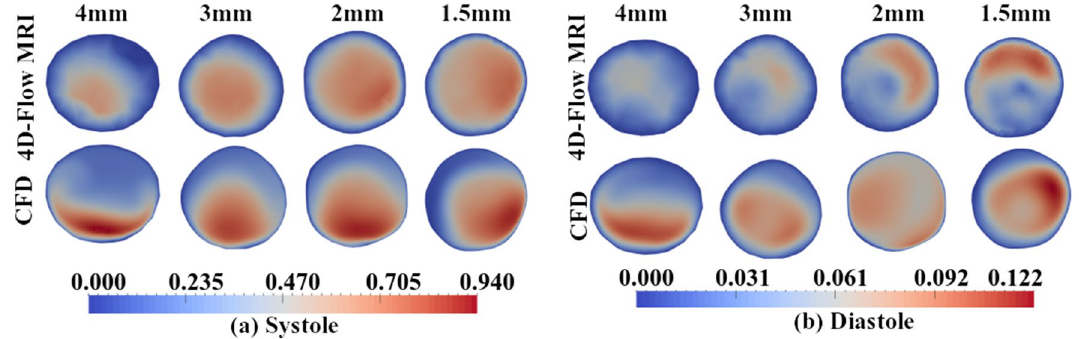
1 ) contours over an axial slice in the mid